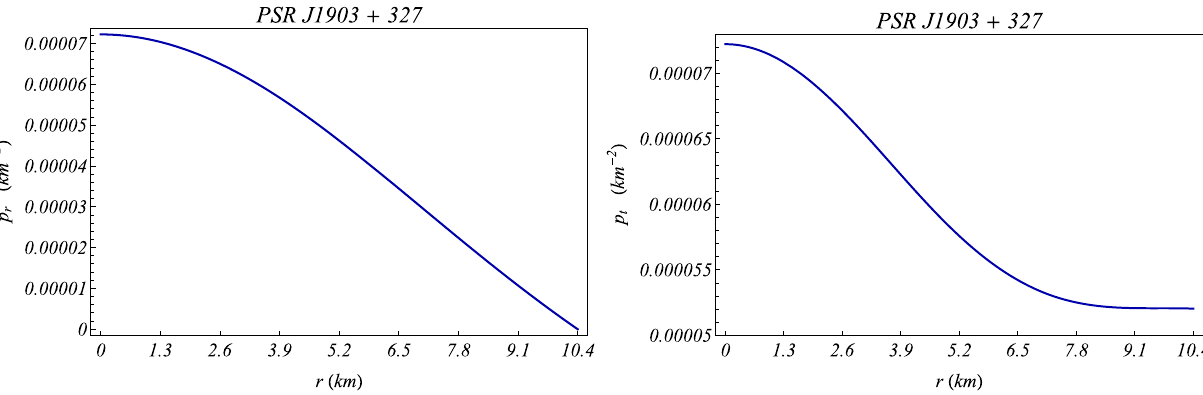
Fig. 1 (Left) The metric potentials and (right) the matter density ρ are plotted against r inside the stellar interior for the compact star PSR J1903+327